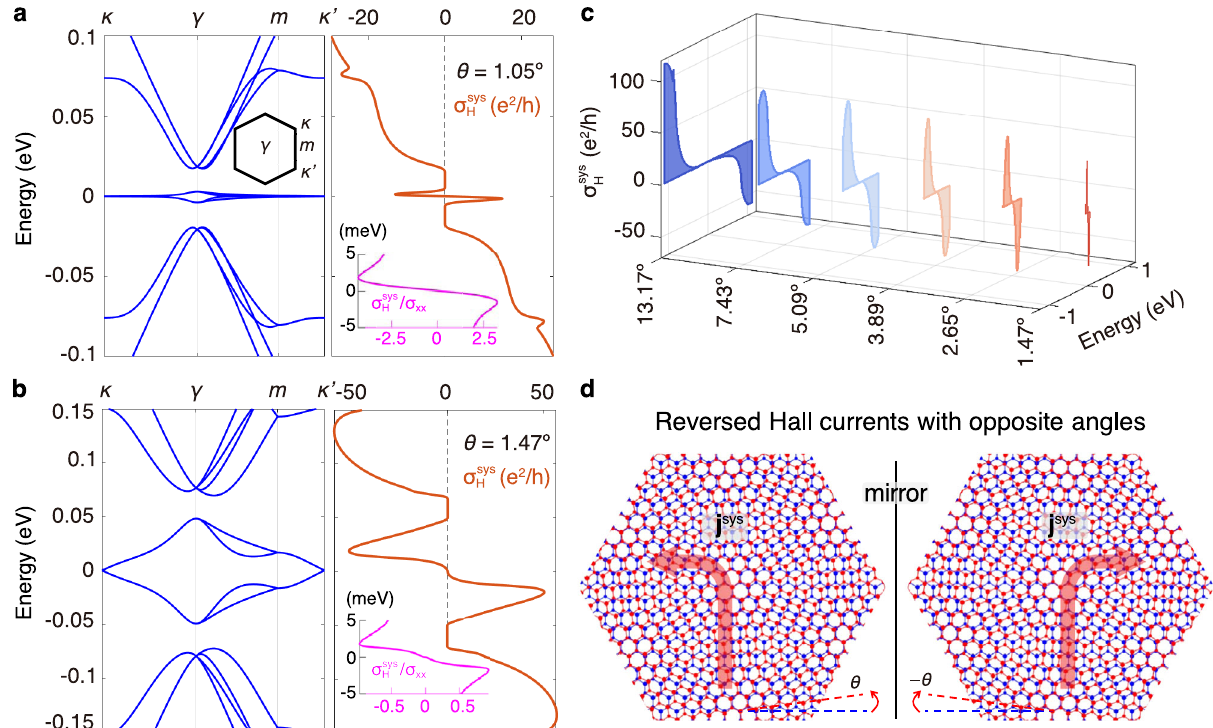
Fig. 2 | Band structure and TR-even Hall conductivity for tBG at different θ . a θ =1.05 ∘ . b θ = 1.47 ∘ . Insets: Hall ratio of Hall conductivity σ sys H to the long- itudinal conductivity σ xx when the Fermi level is within the central